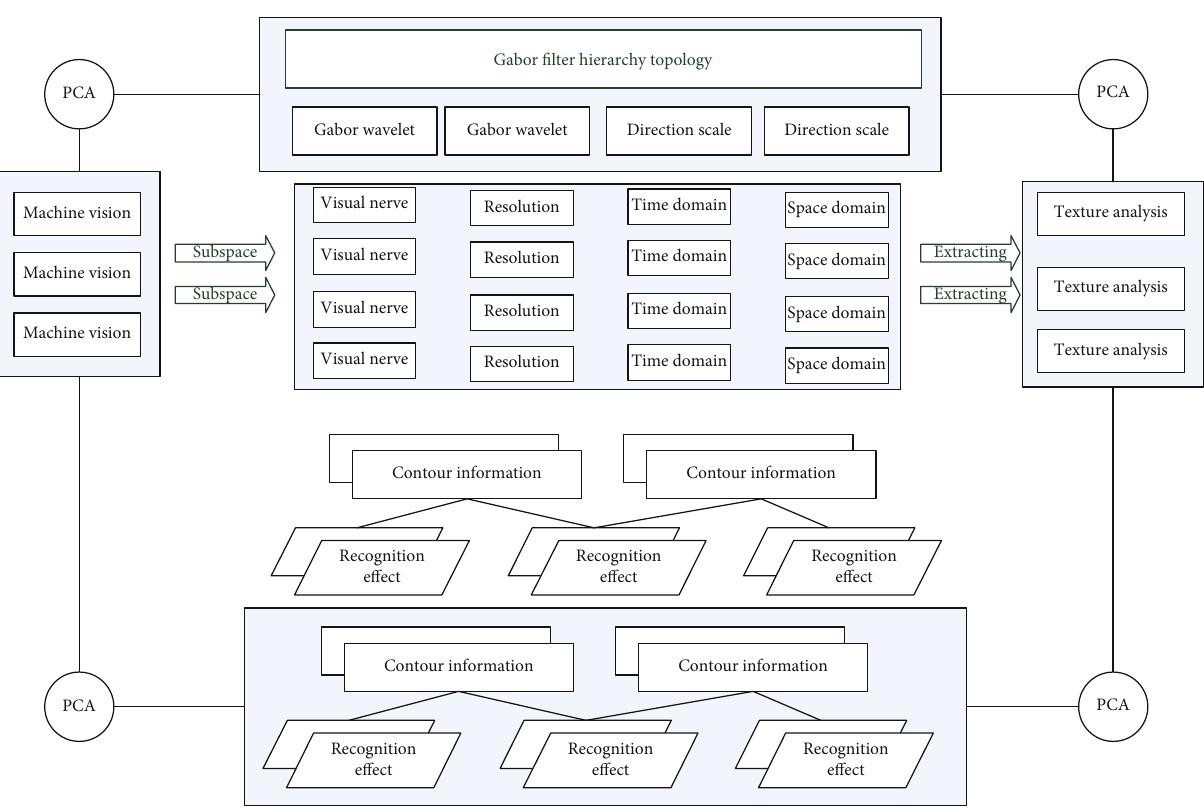
Figure 1: Gabor fi lter hierarchy